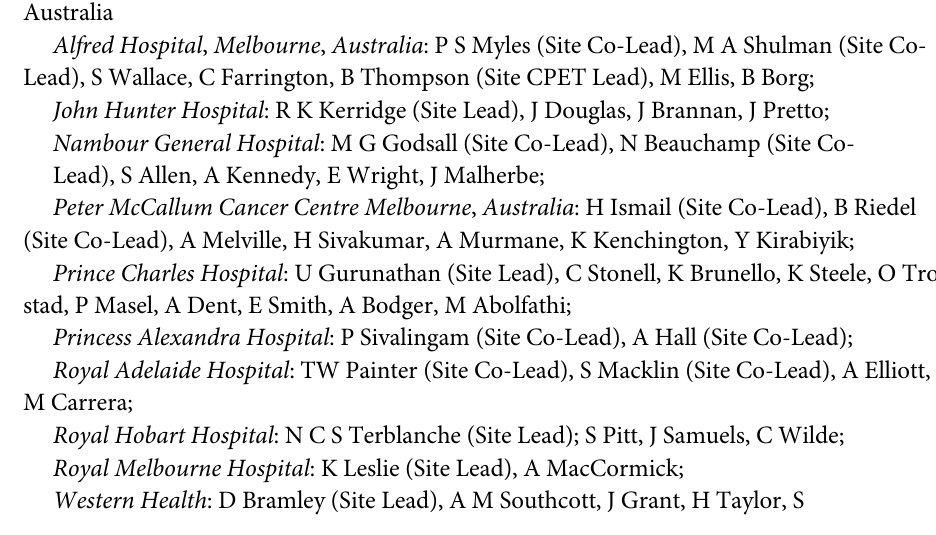
S6 Table. Relationship between magnitude of HRR and other factors associated with more rapid discharge from hospital after surgery. S1 Fig. Serial changes in POMS-defined morbidity on postoperative days 3 and 5. S2 Fig. Delayed heart rate recovery and CPET markers of severe cardiac failure. S3 Fig. Delayed heart rate and postoperative